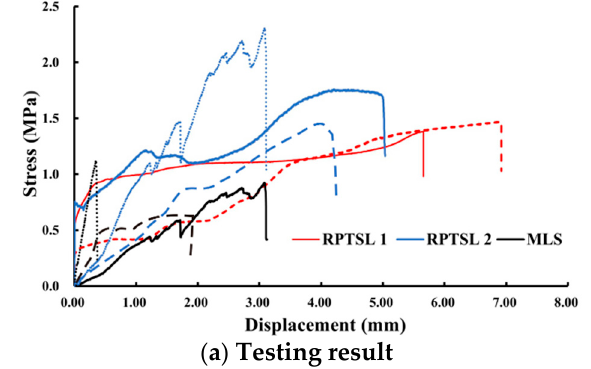
Figure 11. Shearing test result.